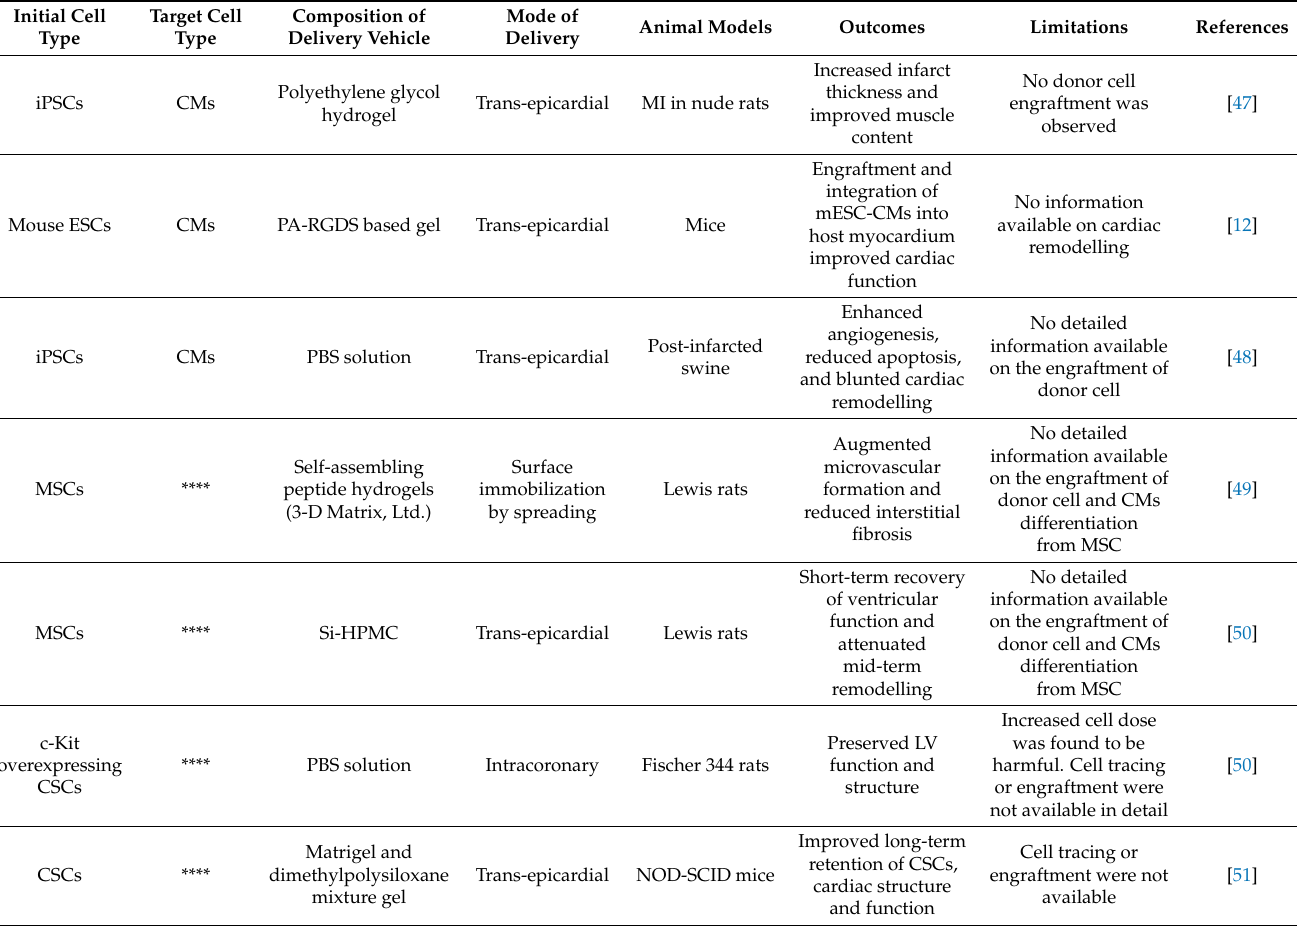
Table 1. Description of the cells delivered to the heart by injection. This cell delivery approach has used various cell types including ESCs, iPSCs, MSCs, and